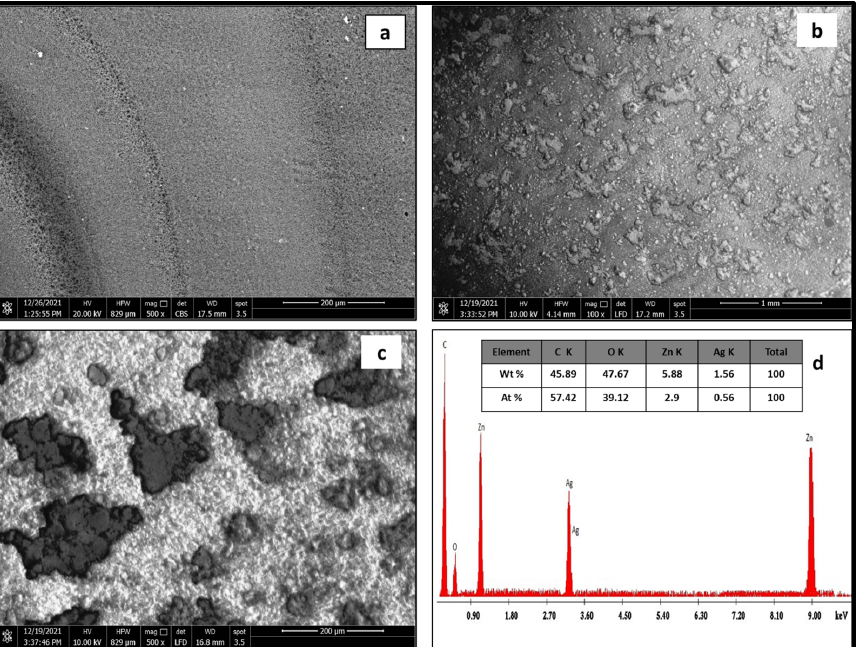
Figure 3. SEM micrographs of pristine CA ( a ) CA@Ag (0.1) /ZnO hybrid material at low ( b ) and high magnifications of ( c ) and EDX analysis of CA@Ag (0.1) /ZnO hybrid material ( d ).